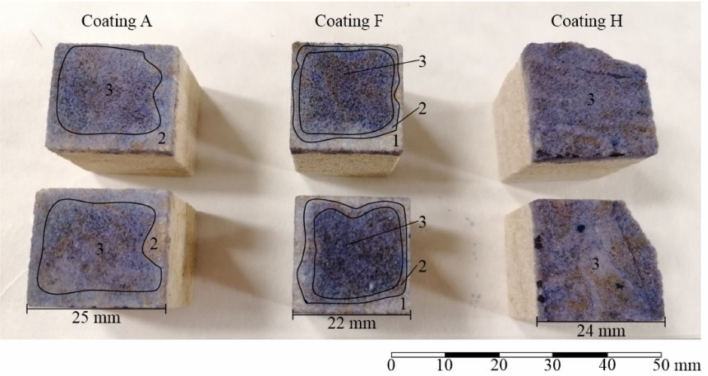
Figure 4. Test of the impregnation penetration depth—HS. 1—hydrophobic zone, 2—partly hy- drophobic zone, 3—not impregnated.